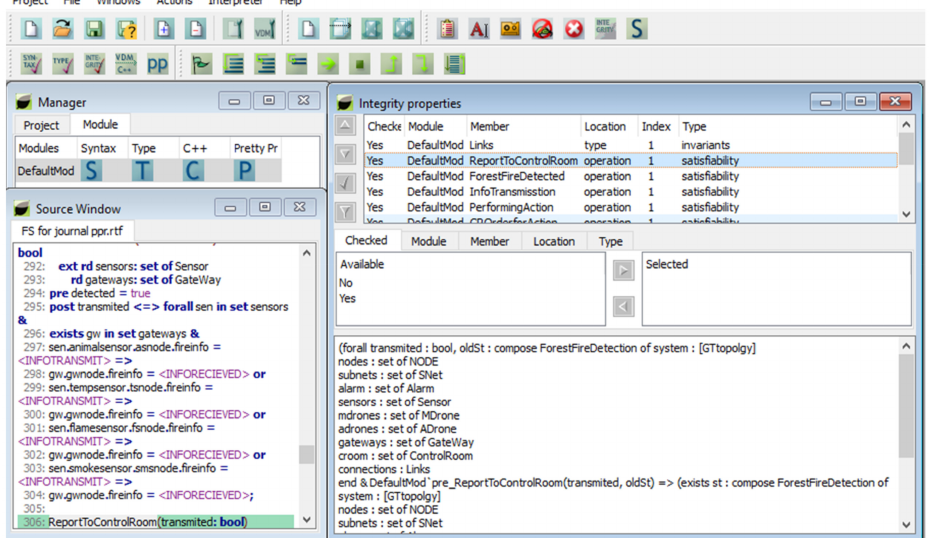
Figure 4. Proof of formal analysis for forest fire detection and counteraction system.